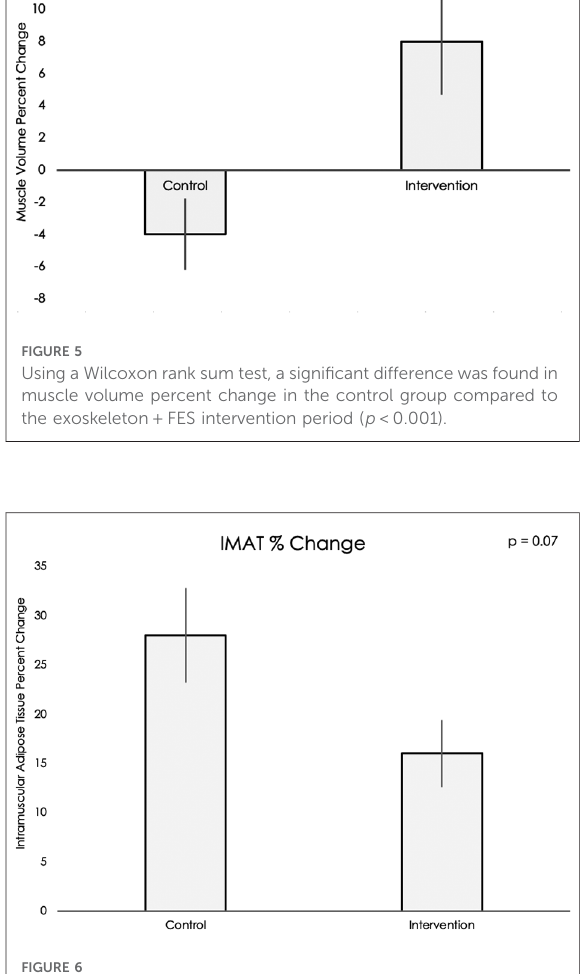
FIGURE 6 Using a Wilcoxon rank sum test, a trend was found for muscle fat in fi ltration percent change in the control period compared to the exoskeleton+FES intervention period ( p